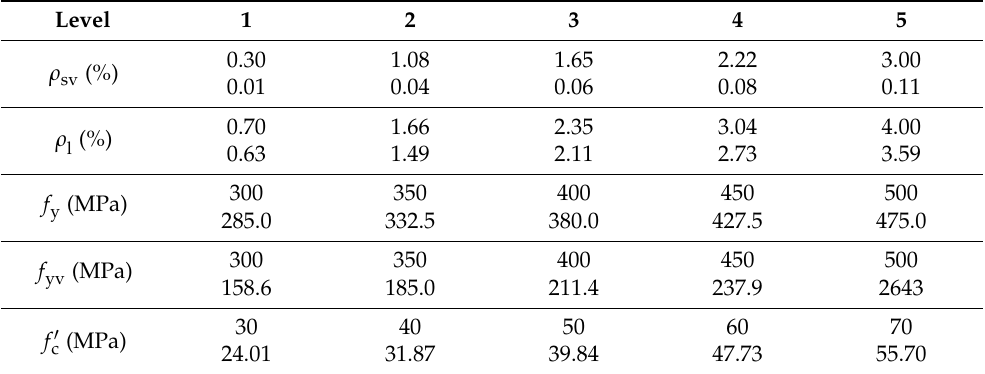
Table 7. Ranges of